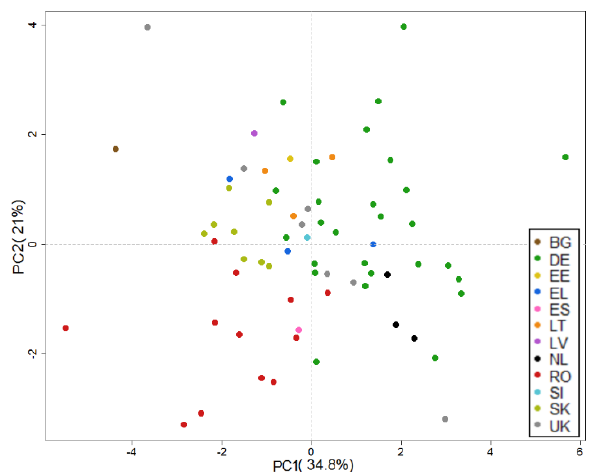
Figure 5. Spatial distribution of FUAs according to the first and second principal components (PC1 and PC2). The abscissa axis divides FUAs based on diversity and uniformity features. The ordinate axis clusters FUAs according to their configuration and size. Country codes are as in Figure